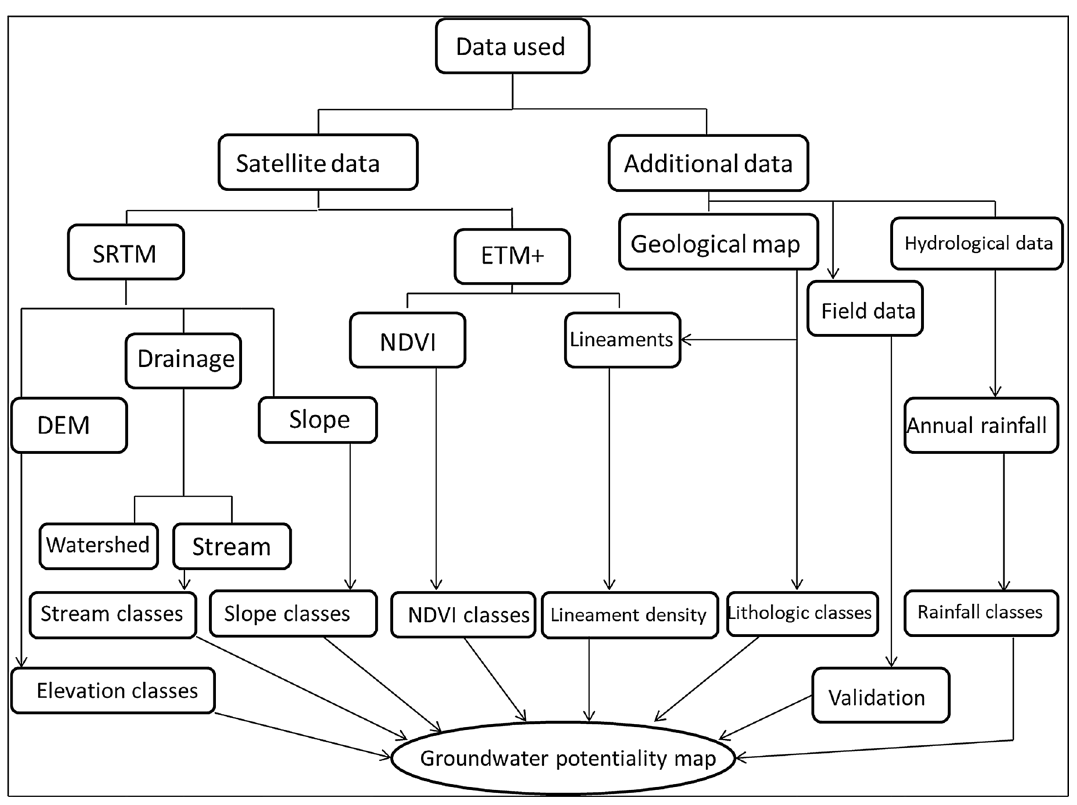
Fig. 4 Flow chart summarizing the approaches Topography layer The land elevation estimates the runoff flow direction and